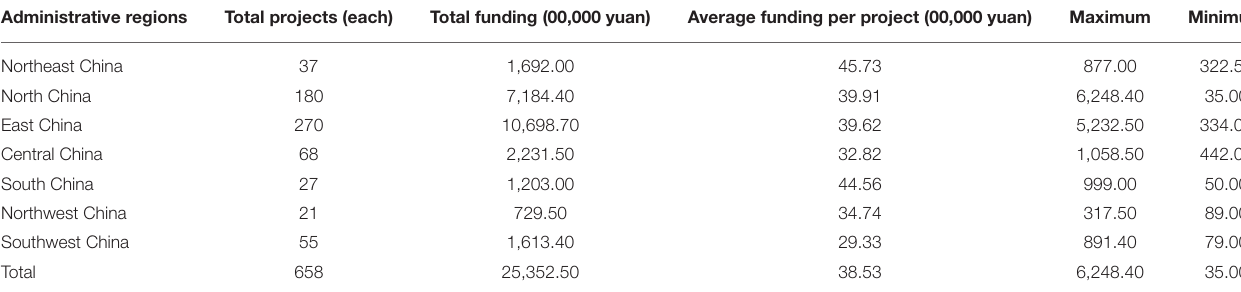
TABLE 5 | R&D input in rare diseases by NSFC by seven major geographical regions. Administrative regions